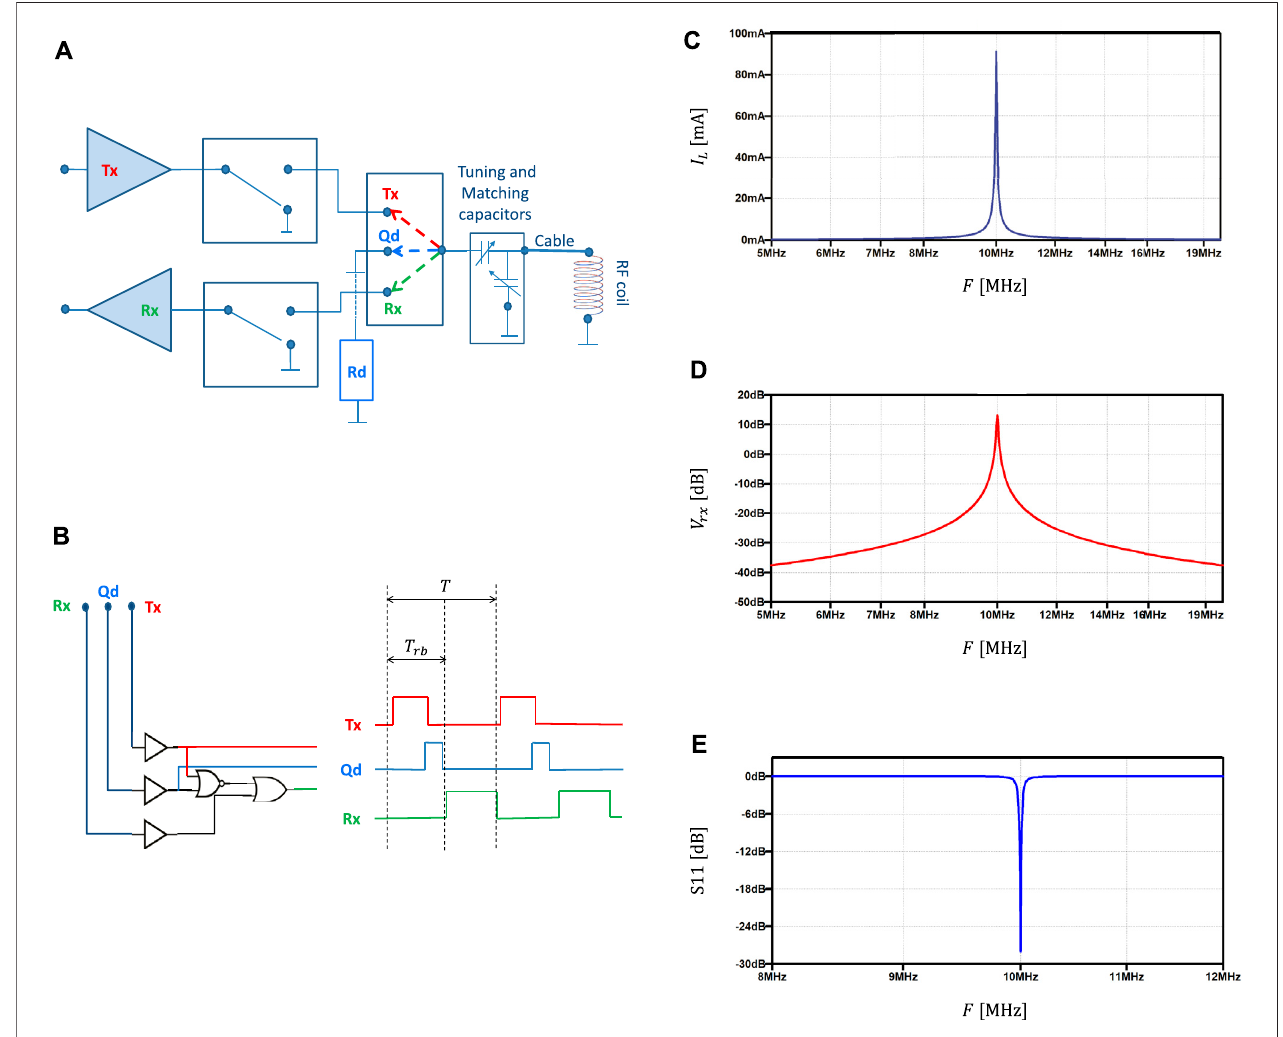
FIGURE 2 | Three state transceiver. (A) Conceptual block scheme including transmitter, receiver, Q damping resistor, three way switch, tuning and matching capacitorsandRFcoil. (B) Exampleoflogiccircuit(threecommandlines)drivingthethreestatetransceiverovertransmit,Q-dampingandreceivestatesateachRFpulse repetition time T . The receiver blank time T rb spans over transmit and Q-damping states. (C) Current through the RF coil I L [ mA ] for a 1 V , AC input, as function of the working frequency F [ MHz ] . (D) Voltage gain of the LC network during receive operation V rx [ dB ] , as function of the working frequency F [ MHz ] . (E) Return loss S 11 [ dB ] , in case of impedance matching with 50 Ω , as function of the working frequency F [ MHz ]